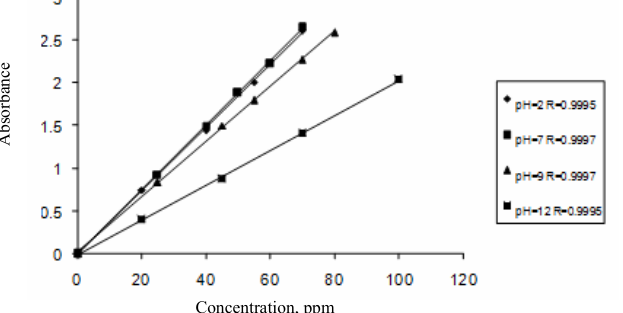
Figure 1. Calibration curve of tolonium chloride at buffer pH of 2, 7, 9 and